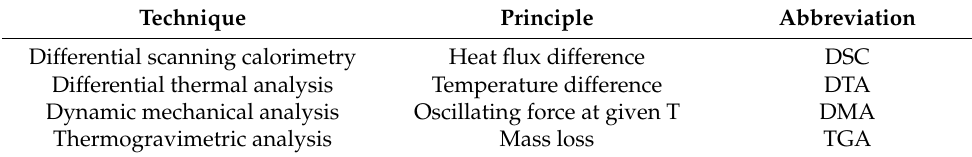
Table 1. Thermal analysis